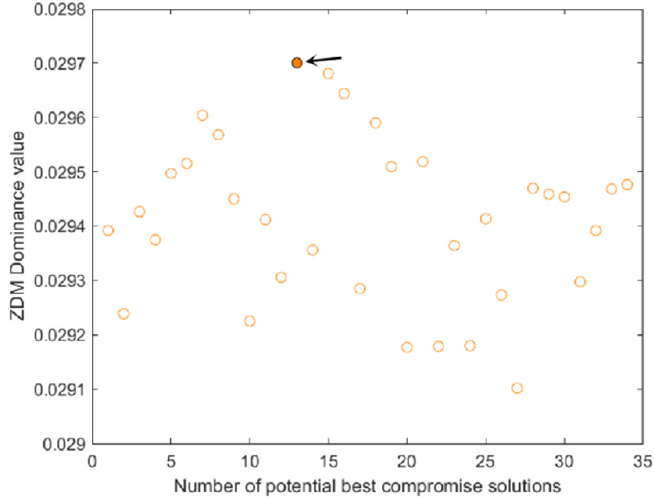
Figure 14. The dominant value of the potential optimal compromise solution of ZDM.